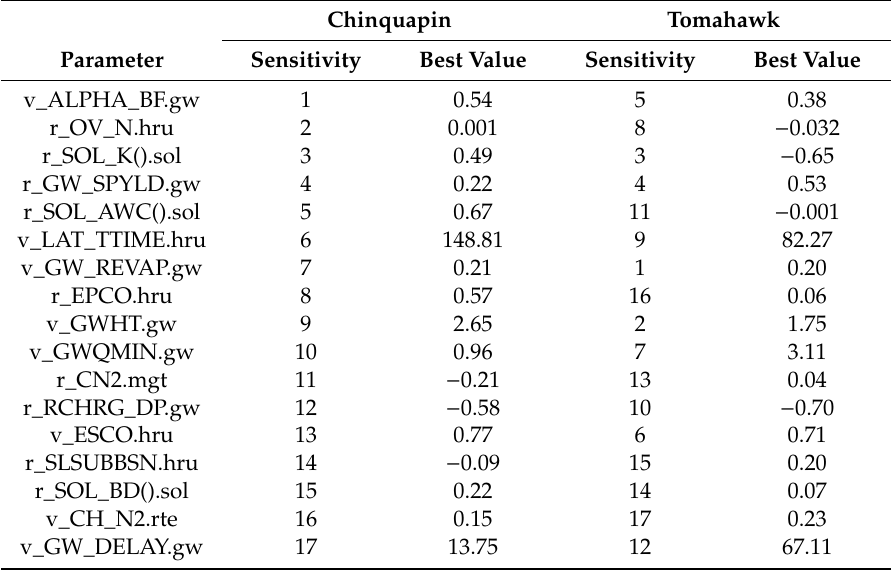
Table 7. Parameter best value estimates and sensitivity rankings using SUFI-2 in SWAT-CUP for the Black and Northeast Cape Fear basins for the validation years